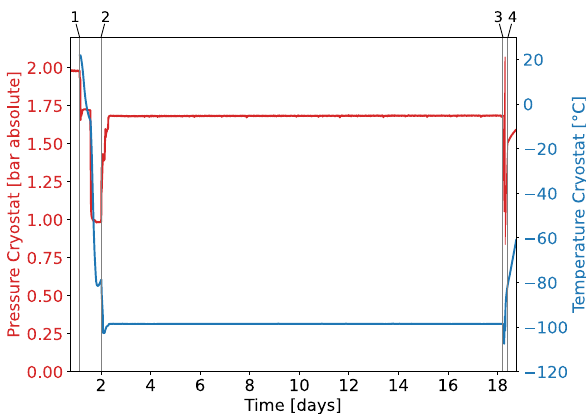
Fig. 7 Evolution of temperature (in blue) and pressure (in red) during the 222 Rn measurement. After filling the cryostat, the cool-down phase is started (1). Additional GXe is filled and liquefied (2). After reaching the required LXe level, the xenon recirculation is started and the mea- surement begins. The measurement ends with the recuperation of the LXe (3). About 1bar of GXe is left in the cryostat and recirculated, to speed up the warming-up time